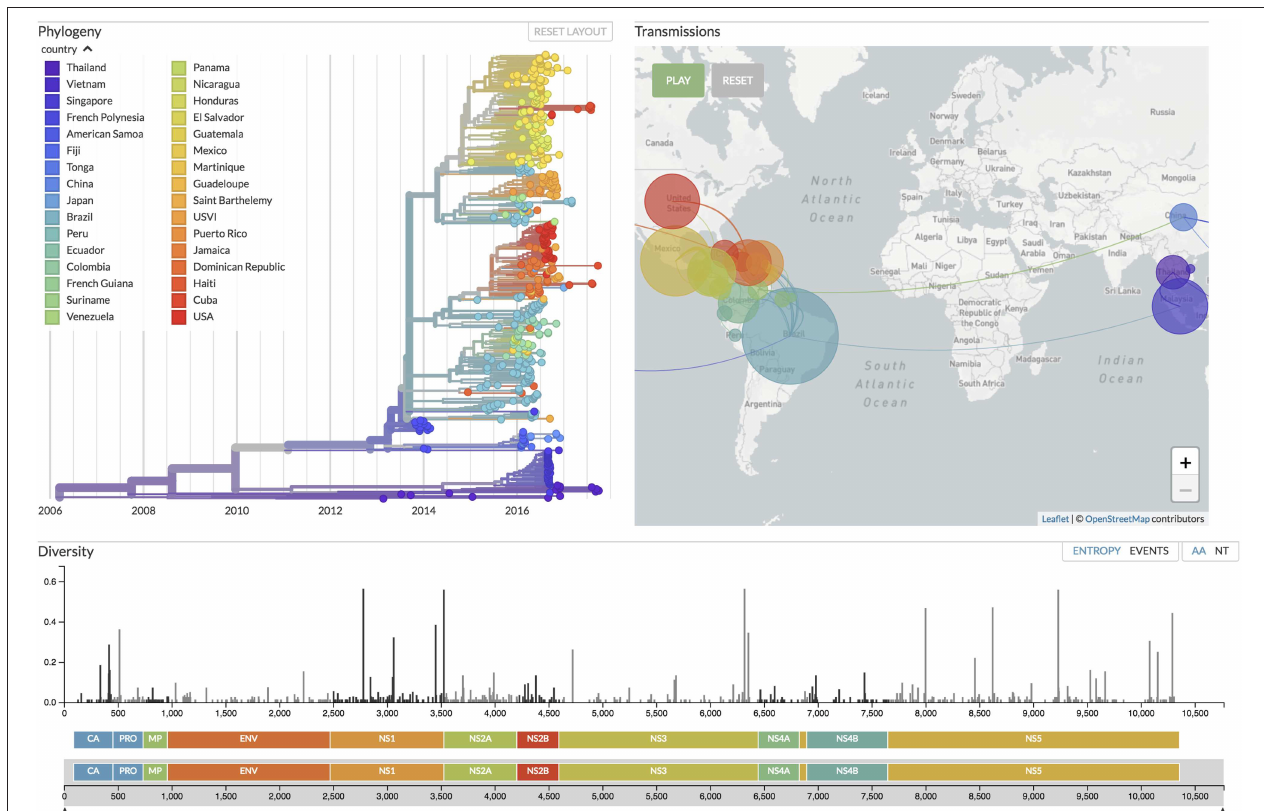
FIGURE 5 | Focusing on real-time tracking of several viruses, Nextstrain (19) provides up-to-date visualizations of phylogenetic and phylogeographic analyses, the latter with an animation over time similar to SpreaD3 ( 40). Shown here is the current situation for Zika virus evolution, based on analyses of 506 genomes sampled between February 2013 and September 2017 from 32 countries around the world (see the figure legend), corresponding to samples taken in 6 different regions of the world: China, Southeast Asia, Japan and Korea, Oceania, South America, and North